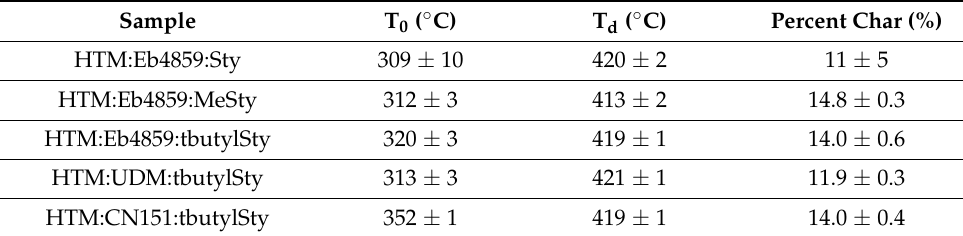
Table 7. TGA data of 3D printed HTM